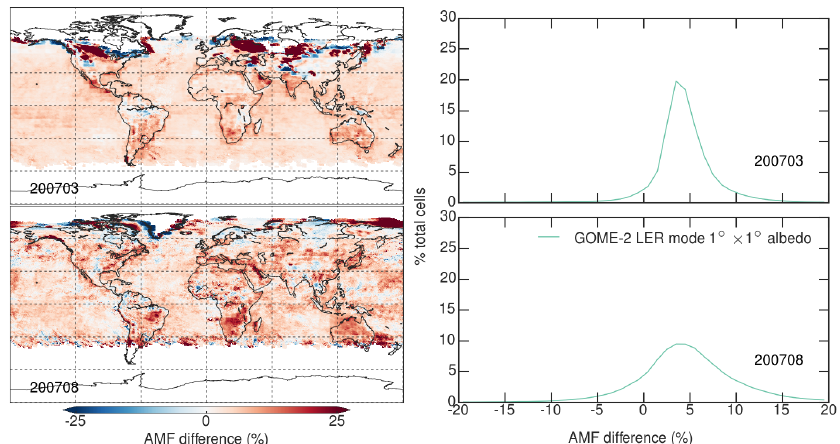
Figure 7. Left: spatial maps of the AMF differences resulting from the use of the temporally interpolated and area-weighted GOME-2 1 ◦ × 1 ◦ 340nm mode LER (Tilstra et al., 2014), as discussed in Sect. 5, relative to the default UoL AMF algorithm i.e. 100% × (new AMF – baseline AMF)/naseline AMF. The AMFs are gridded on to 0.25 ◦ × 0.25 ◦ using observations with cloud fractions ≤ 40%. Right: corresponding histograms of the AMF